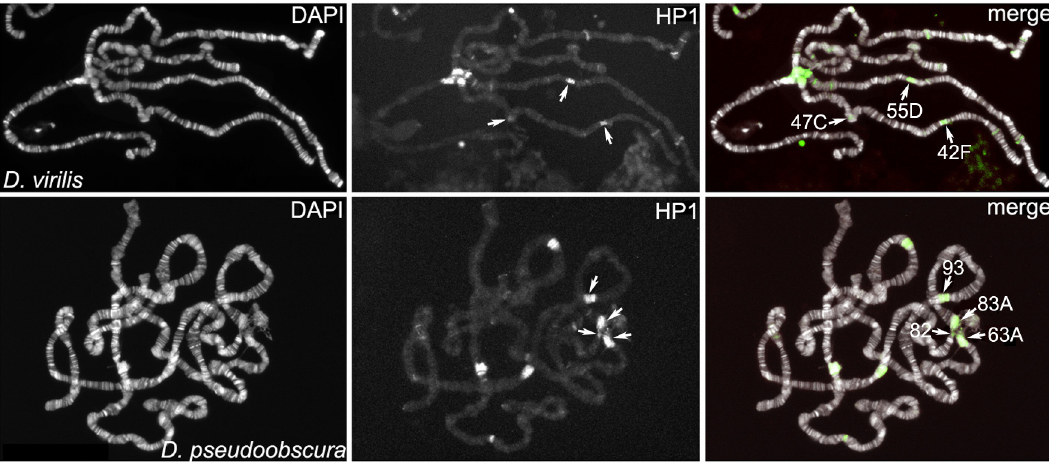
Fig 6. Immunolocalization of HP1a on polytene chromosomes. HP1a distribution is shown on polytene chromosomes of D . virilis (upper panels) and D . pseudoobscura (lower panels). The HP1a fluorescence signals clearly marks Dvir_42F- 43A, Dvir_47C and Dvir_55D and to Dpse_63A, Dpse_83A, Dpse_82AB and Dpse_93. Three additional strongly stained regions are present in D . pseudoobscura